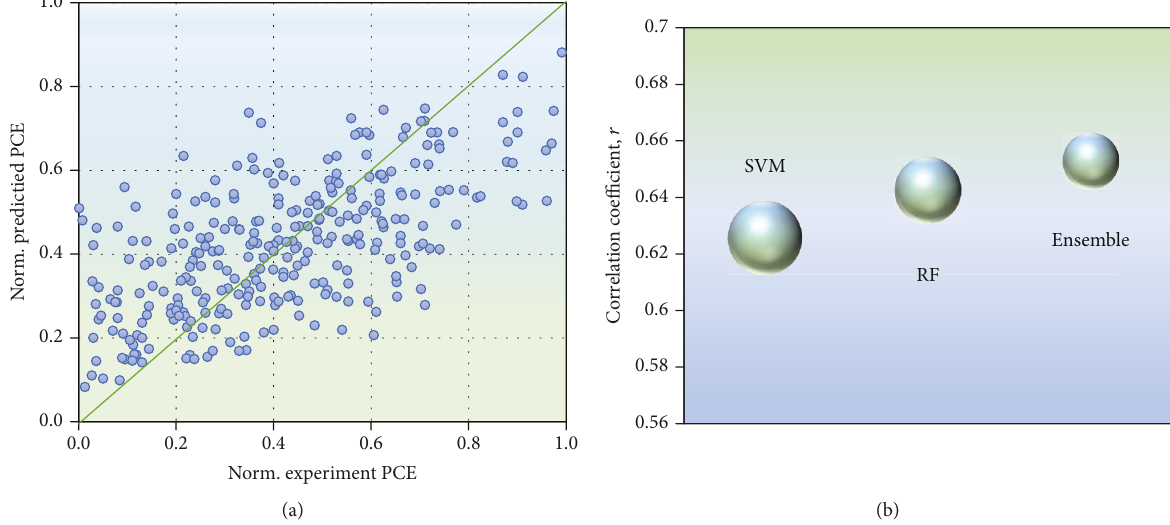
Figure 4: (a) The performance of the ensemble learning through averaging of the PCE values from the previous SVM and RF models. (b) Summary of the three models in this study. Note that the diameter of each bubble represents the relative size in quantity for the standard derivatives of the correlation coe ffi